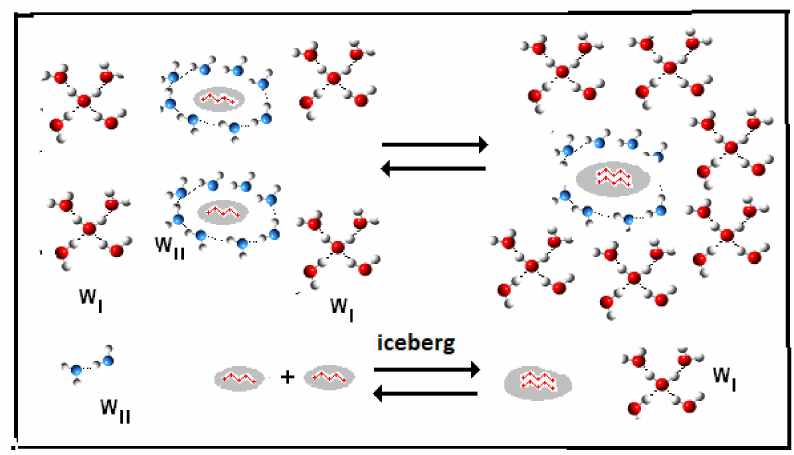
Figure 7. Class B. Iceberg coalescing, with iceberg reduction. From the coincidence of the value of entropy at zero iceberg ∆ S 0( ξ w = 0) = –86.4J K − 1 mol − 1 , (see reference [5]) with the Trouton constant ∆ H eb / T eb = ∆ S evap = +86.9 ± 1.4 J K − 1 mol − 1 , we can infer that the passage of gas molecules from the free state (Figure 8) to the trapping into the solvent implies a change in entropy (as change in kinetic energy) that is exactly the opposite of that for the passage from liquid state to vapor state (i.e., configuration entropy change for the condensation of gas is equal to the opposite of evaporation, – ∆ S evap ).